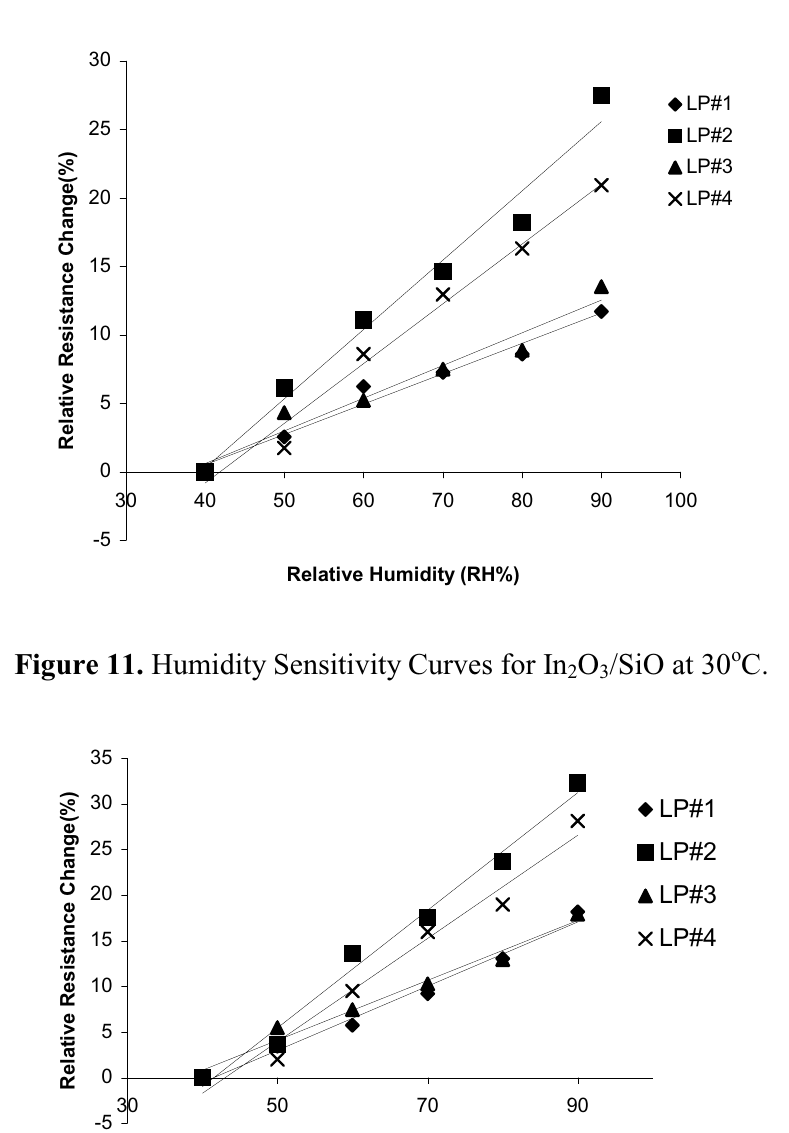
O /SiO at 60 o C. 2 3 O /SiO 2 3